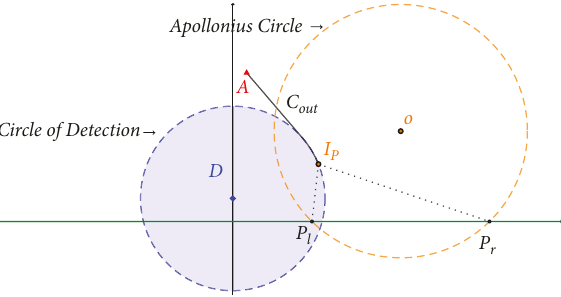
Figure 4: The position relation between the I circle and the target